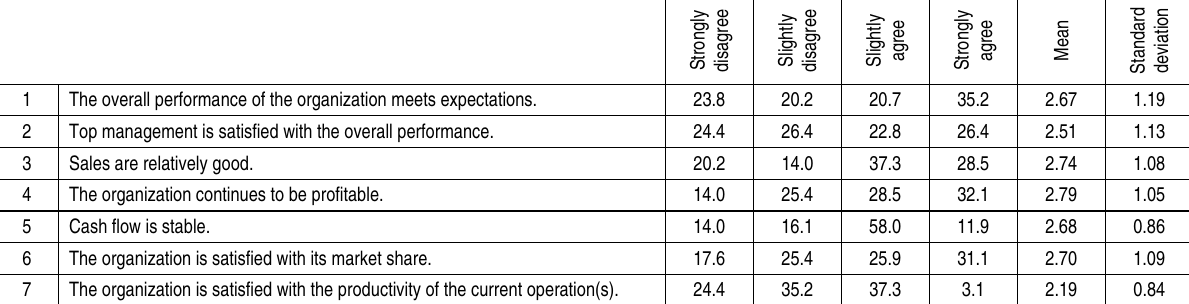
Table 2. Mean scores in ranking order for perceived business performance